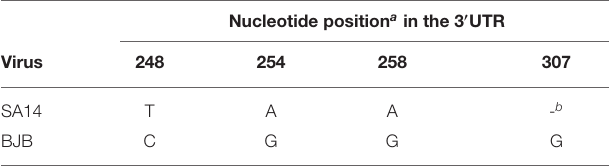
FIGURE 1 | The pathogenicity and growth rate of SA14 and BJB viruses in vivo and in vitro . The SA14 and BJB viruses were injected intraperitoneal into SPF BALB/c ( n = 5) mice using a dose of 10 6 TCID 50 /200 µ L. Survival rate (A) and body weight (B) were monitored daily for 13 days. Mice that lost more than 25% of their initial weight were euthanized. (C) BHK-21 cells seeded in 12-well plates were infected with SA14 or BJB viruses at a multiplicity of infection (MOI) of 0.001. Culture supernatant was then collected at 24, 48, and 72 hpi and subjected to TCID 50 on BHK-21 cells. Data are shown as means ± SD ( n = 3), and significance was calculated using an unpaired t -test (* P < 0.05; ** P < 0.01). TABLE 1 | Differences of nucleotide in the 3 ′ UTR between SA14 and BJB. Nucleotide position a in the 3 ′